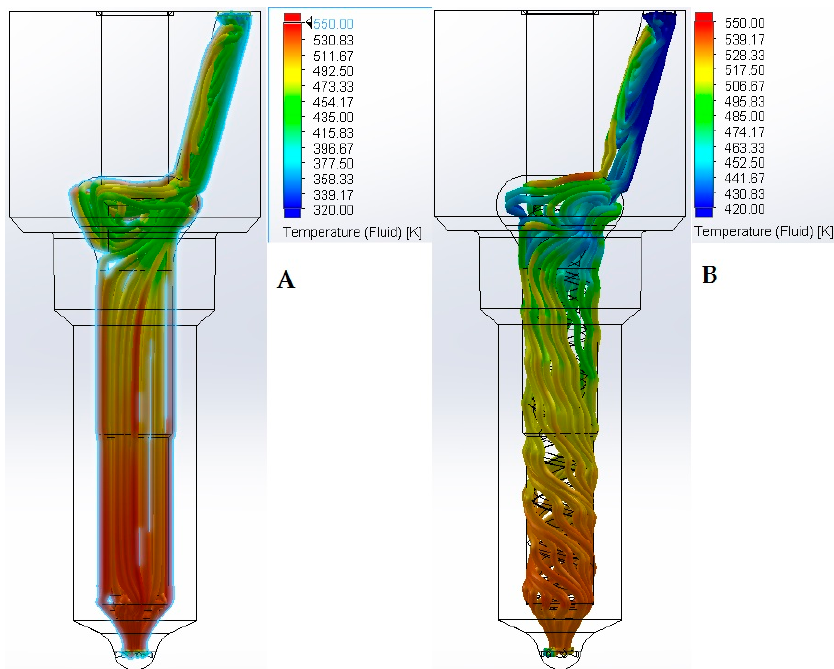
Figure 7. The results of preliminary simulation studies of the flow and temperature distribution of the fuel through the standard and modified atomizer. Flow parameters: injection dose: 35.3 mm 3 /H, injection time: 780 µ s, pressure in the system: 135 MPa. ( A ) Standard atomizer; ( B ) modified atomizer.